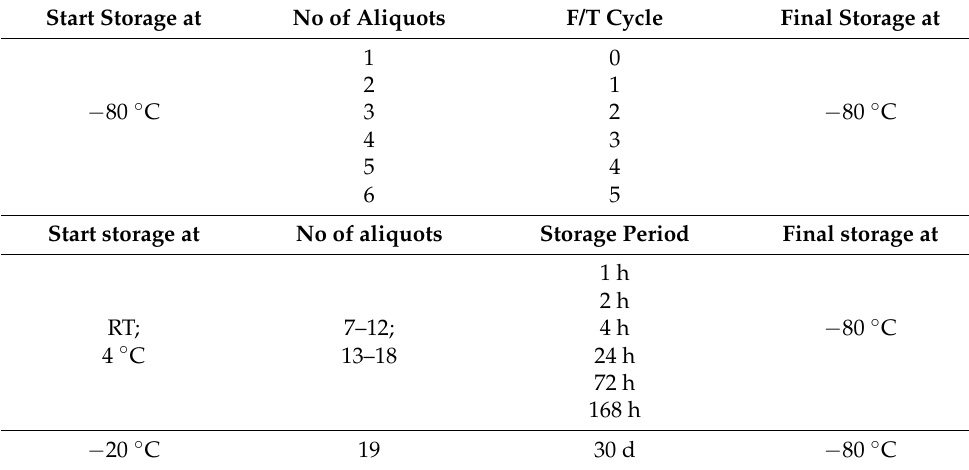
Table 1. The protocol of plasma and serum sample stability testing. Start Storage at No of Aliquots F/T Cycle Final Storage at 1 0 2 1 − 80 ◦